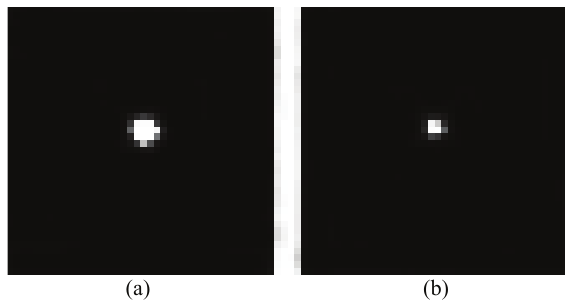
Figure 4. Facula of LED marker: ( a ) at a distance of 2 m and ( b ) at a distance of 5